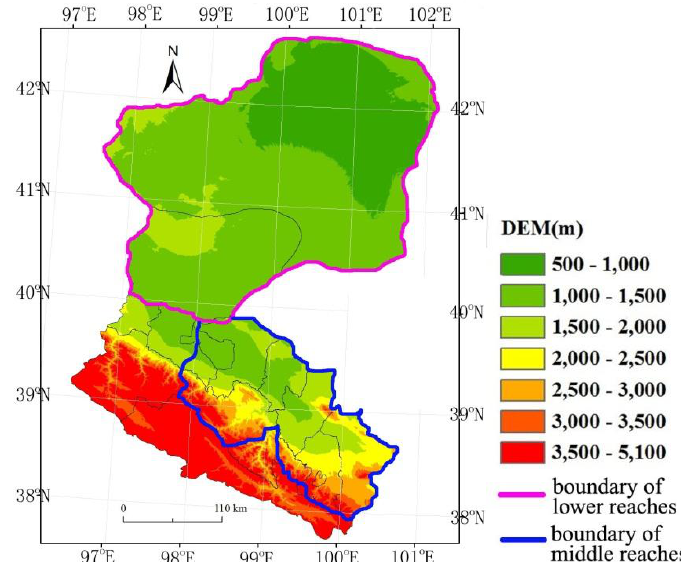
Figure 2. DEM (Digital Elevation Model) map and the administrative division of the Heihe River